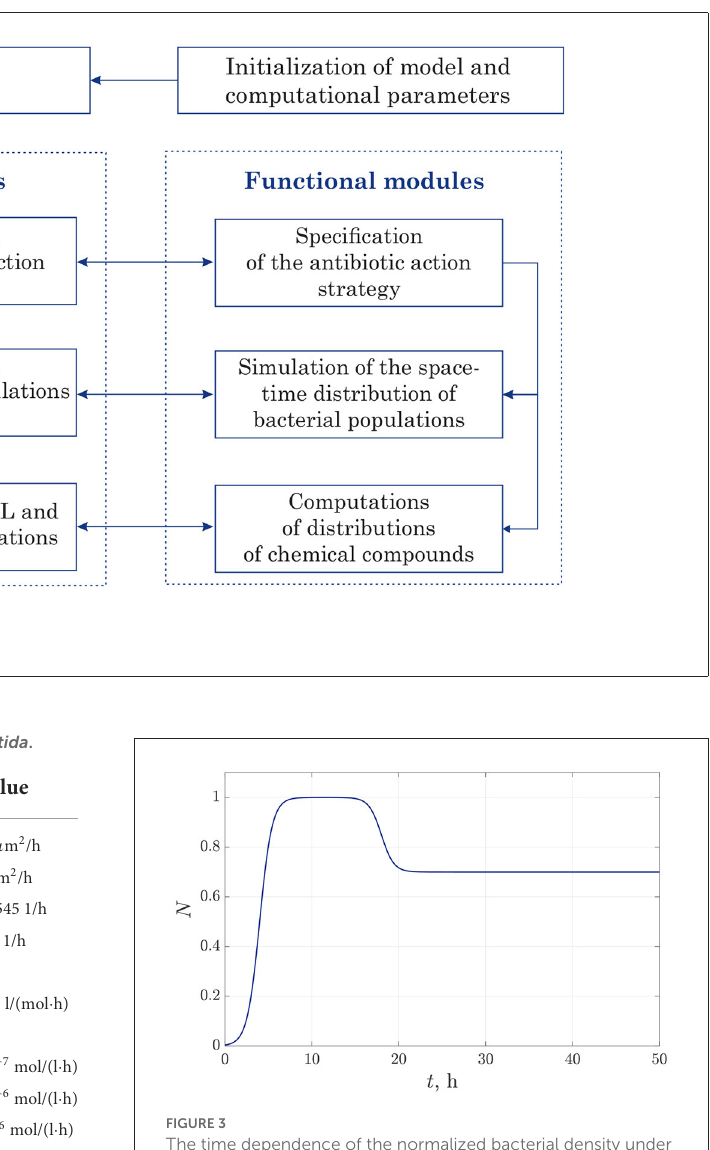
FIGURE3 The time dependence of the normalized bacterial density under single antibiotic treatment.